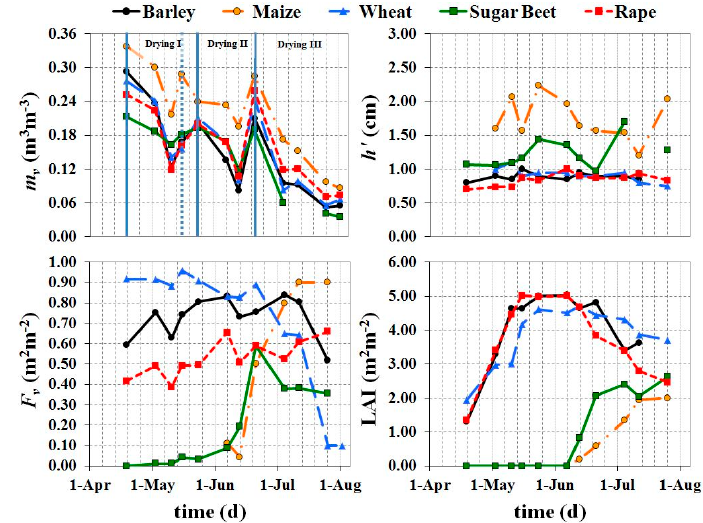
Figure 3. Temporal dynamic of spatially averaged m v , h’ , F v and LAI . Blue bars mark m v peaks separating consecutive drying periods occurred at all crops except for maize in which the second drying period was shorter (see the dashed bar).